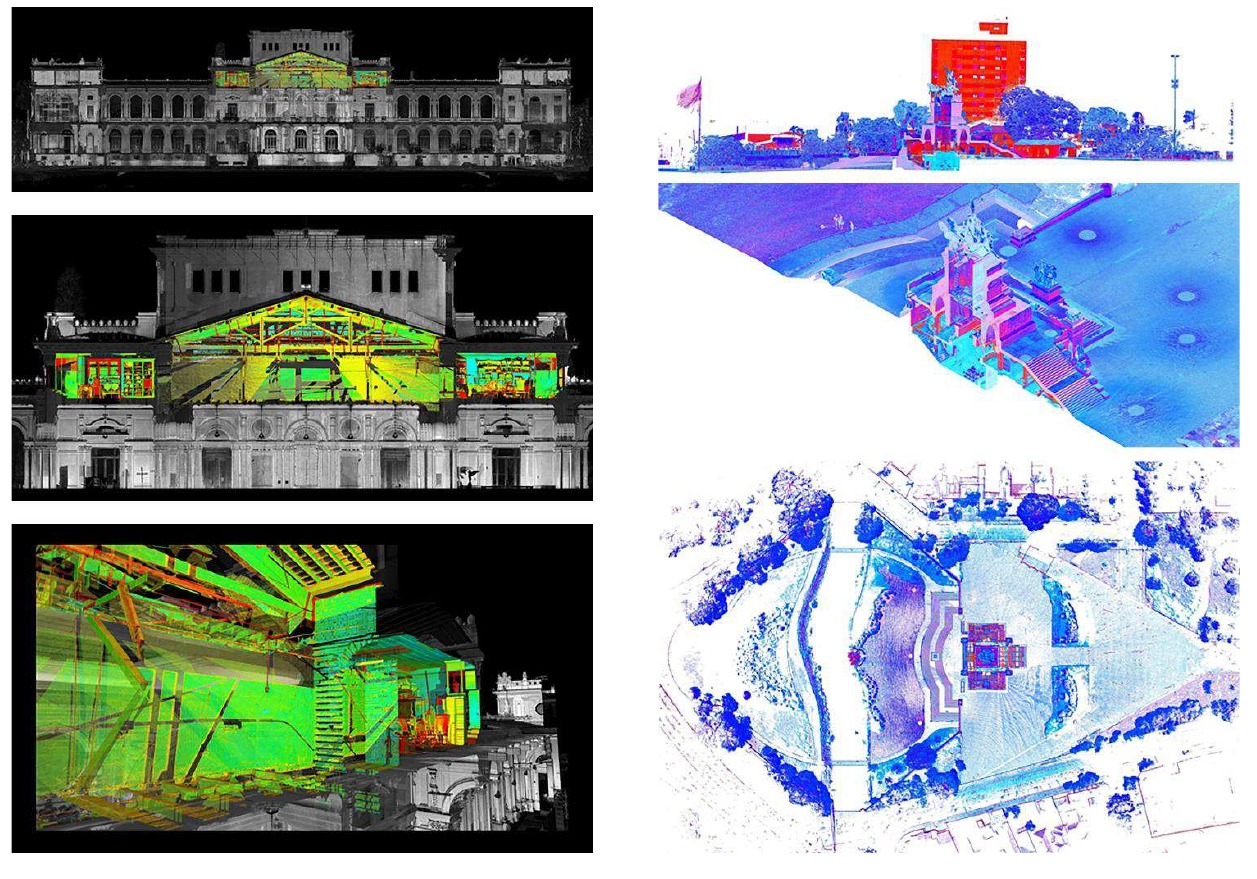
Figure 7. Digital Elevation Model, DEM, Monumento à Independência do Brasil; longitudinal section; axonometric cutaway; planimetry of the imperial crypt.